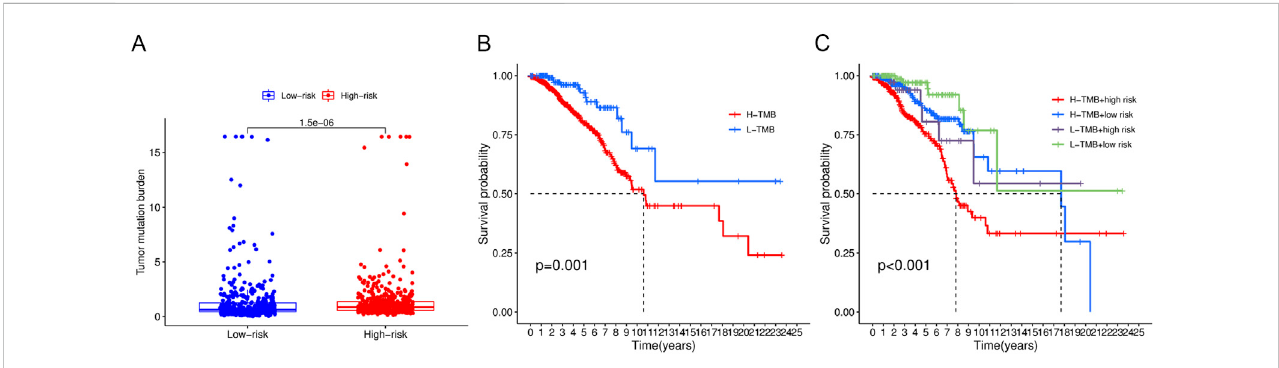
FIGURE 10 Tumor mutational burden analysis. (A) Boxplots demonstrated a higher TMB in the high-risk group. (B) Low-TMB group was associated with a favorable survival probability. (C) Patients in the low-TMB plus low-risk group had better prognosis than those in the high-TMB plus high-risk group.